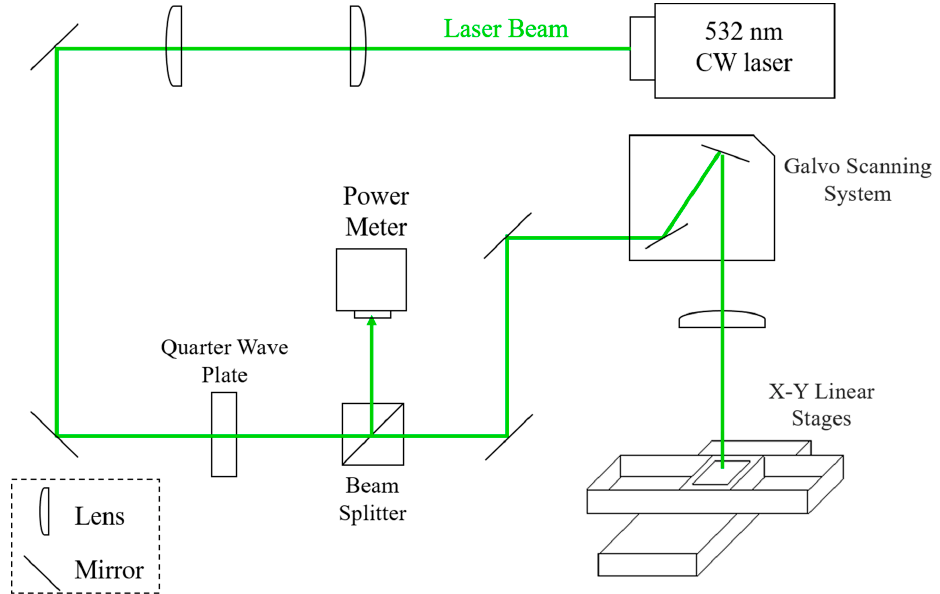
Figure 1. Schematic diagram of the laser scanning system. Silver nanowires, provided by Conjutek Ltd. (New Taipei City, Taiwan), were syn- thesized with the polyol method [7]. The average dimensions of the silver nanowires were 90 nm in diameter and 20 μ m in length. The silver nanowires were transferred onto 50 μ m-thick polyethylene terephthalate (PET) films provided by Nan Ya Plastics (Taipei, Tai- wan) by vacuum filtration [25] to make the AgNWs randomly and evenly distributed. A four-point probe was used to measure the sheet resistance, and a UV-VIS spectrometer equipped with an integrating sphere and tungsten halogen lamps was used as a light source to measure transmittance. The morphology of the AgNWs after laser processing was inspected using a field-emission scanning electron microscope (NOVA NANO SEM 450). 3. Results and Discussion 3.1. Correlation of Sheet Resistance and Transmittance The sheet resistance and optical transmittance of AgNW films are closely correlated and both dependent on the amount of AgNWs deposited on the substrate. We defined a parameter called the surface mass density ( μ g/cm 2 ) (i.e., the mass of AgNWs ( μ g) per unit area (cm 2 )) to quantify the amount of AgNWs deposited on the substrate. A higher surface mass density of AgNWs resulted in a lower sheet resistance, as shown in Figure 2a. When the surface mass density was in the low range of less than about 10 μ g/cm 2 , the sheet resistance increased dramatically with decreasing surface mass density. This was proba- bly because the amount of contact points between AgNWs was significantly reduced when the number of AgNWs per unit area was low, that is, when the AgNWs were sparsely distributed, providing fewer paths for electron transport. When the surface mass density was high, the number of contacts increased dramatically, which provided many more paths for efficient electron transport. On the other hand, a high surface density re- sulted in less light transmission, as shown in Figure 2a (right y -axis), due to the agglom- eration of Ag nanowires at high mass density, resulting in the blockage of light. We took the transmittance at the wavelength of 550 nm in the visible light range as a representative for comparison. The transmission data in the full wavelength range of visible light is